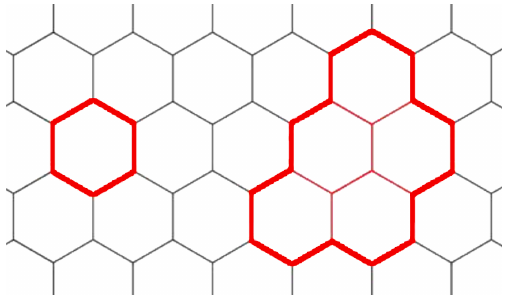
Figure 4. A place (left) and an example of a board (of size 5) (right) on a hexagonal lattice